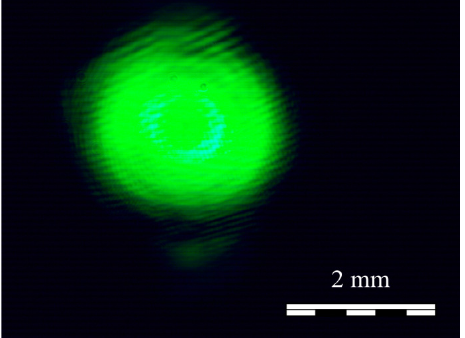
Figure 12. The intensity distribution of the beam from Equation (47) at m = 1 registered by the camera.